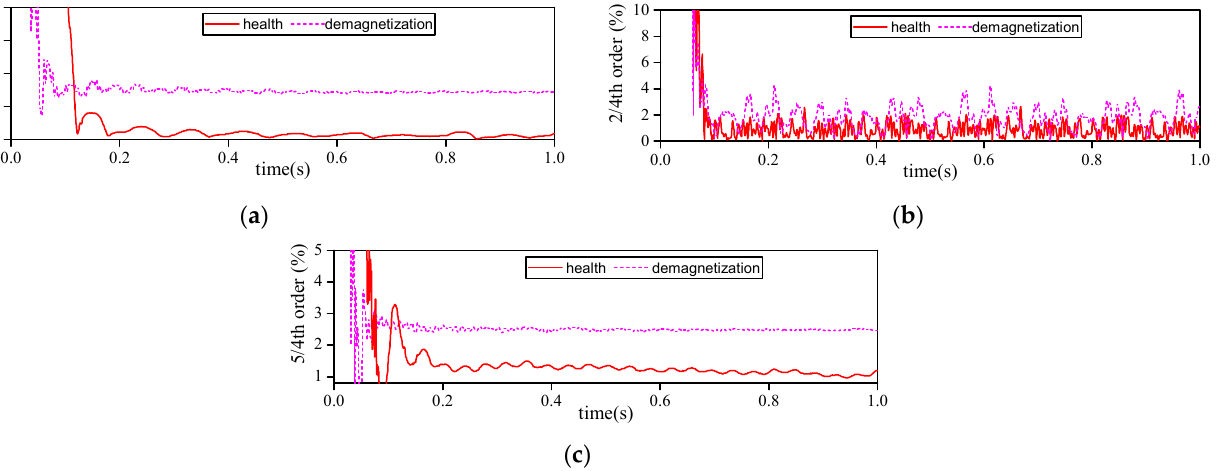
Figure 7. Comparison of harmonics between healthy and partially demagnetized PMSMs under stationary conditions (1000 rpm, 2.6A, in experiment). ( a ) 2/4th-order harmonic, λ = 0.999; ( b ) 2/4th- order harmonic, λ = 0.9; ( c ) 5/4th-order harmonic, λ = 0.9.